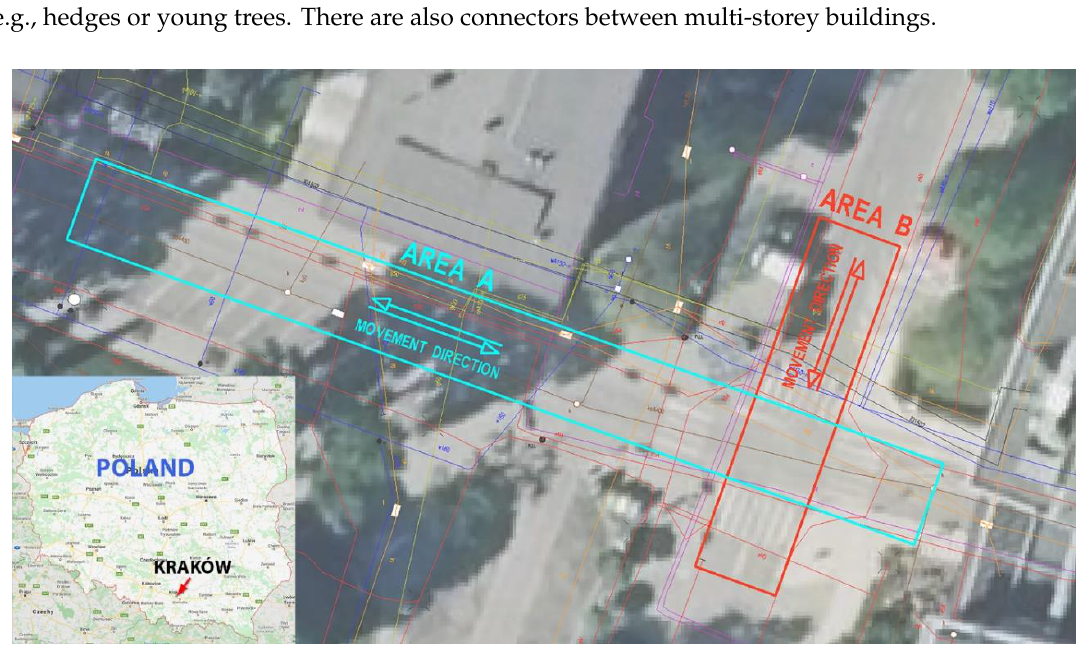
Figure 8. Sketch of measurement location in real condition.